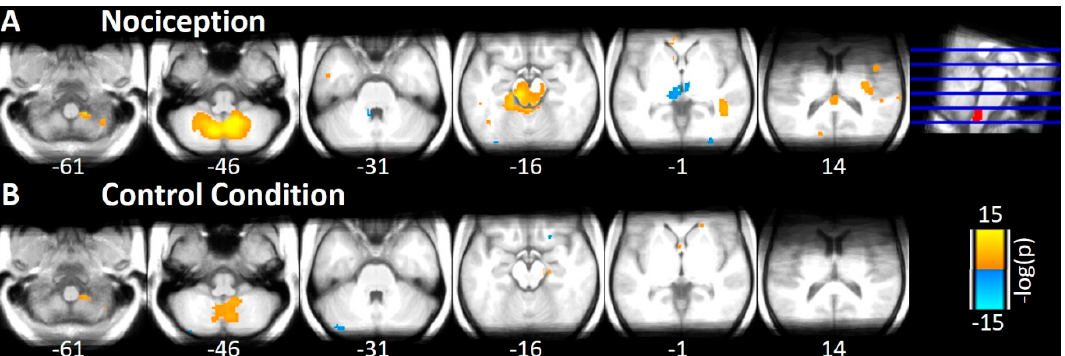
Figure 4. Results of the Partial Similarity analysis. ( A ) Log-transformed significance of partial correlations (Spearman) in trial-to-trial variability between the left STN (marked in red at the top right corner) and cerebellum, brainstem, and midbrain during nociception at a statistical threshold of p < 0.05 (FDR-adjusted) and a minimum cluster extent of 20 voxel. The correlation between the STN and the individual voxel is controlled for general signals from the rest of the volume. ( B ) The same results for the control condition. Positive partial correlations are marked in orange, negative partial correlations are marked in